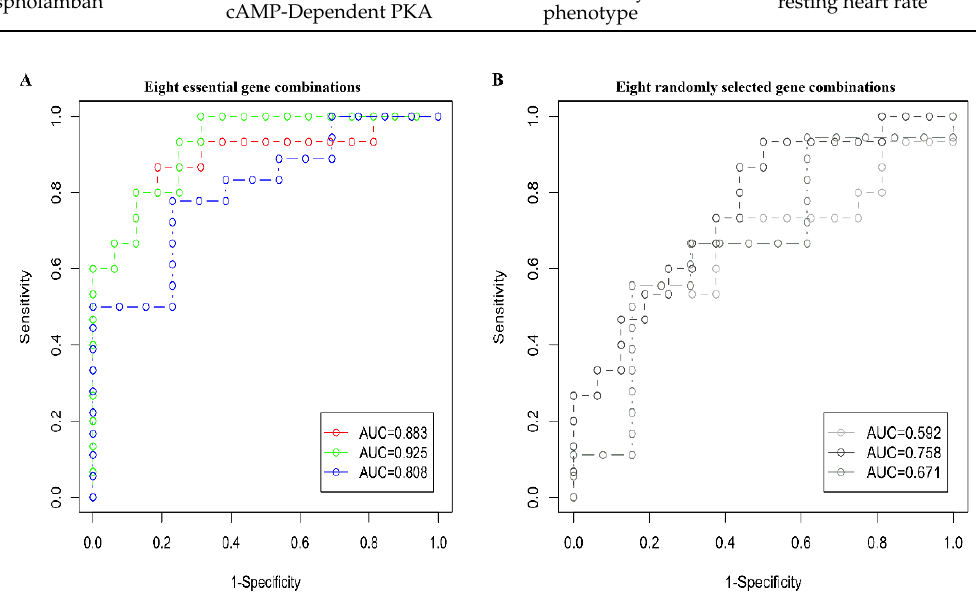
and GSE28829 datasets . The dot represents different genes. The red dot represents the top 20 genes in the corresponding analysis.